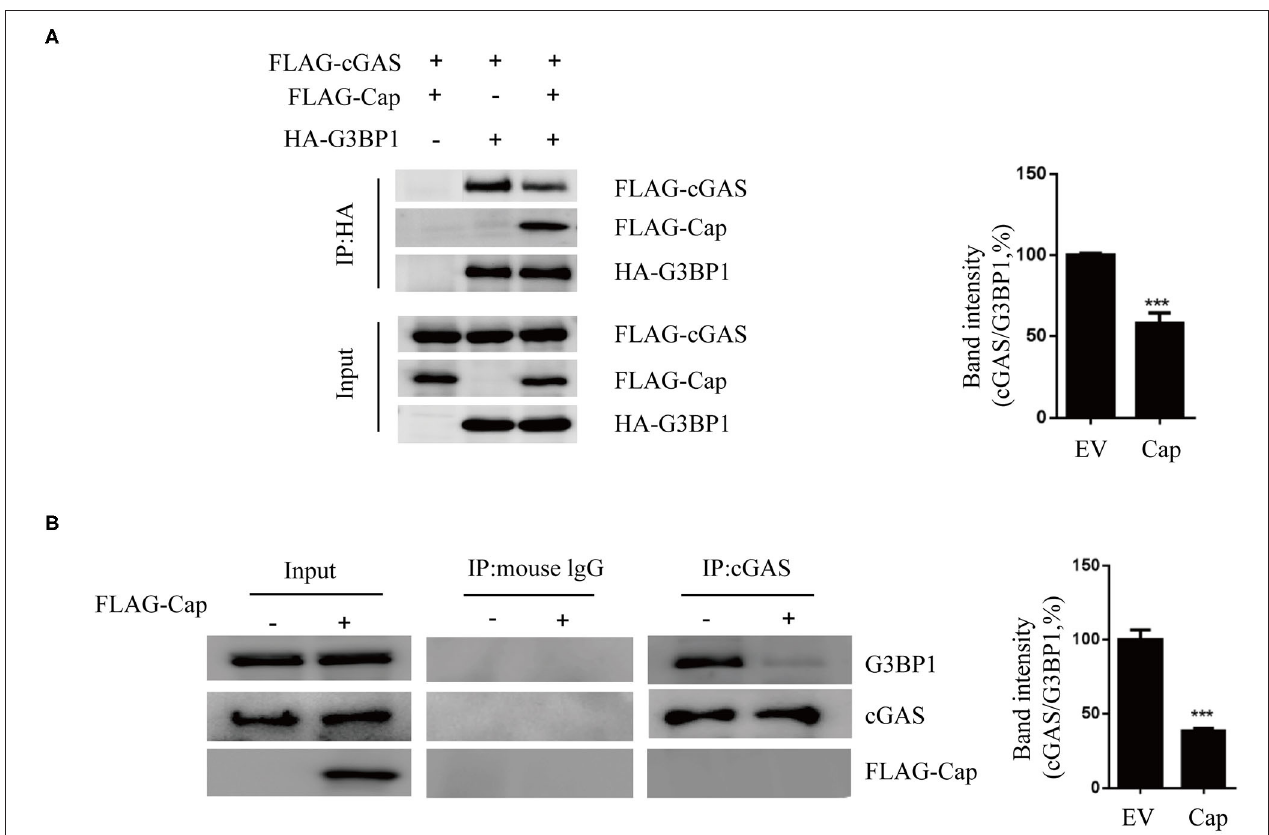
FIGURE 5 | Cap inhibits the interaction between cGAS and G3BP1. (A) Cap reduced the amount of cGAS co-precipitated by G3BP1. HEK 293T cells were co-transfected with FLAG-cGAS, FLAG-cap and HA-G3BP1, or the empty vector (EV). Cell lysates were used for immunoprecipitation (IP) with the anti-HA antibody. IP samples were analyzed by western blotting. (B) Cap inhibited the interaction of endogenous cGAS and G3BP1. PK15 cells were transfected with FLAG-cap or the empty vector. The cell lysates were used for IP with the anti-cGAS antibody, and the IP products were western blotted. The results represent data from three independent experiments, *** p <